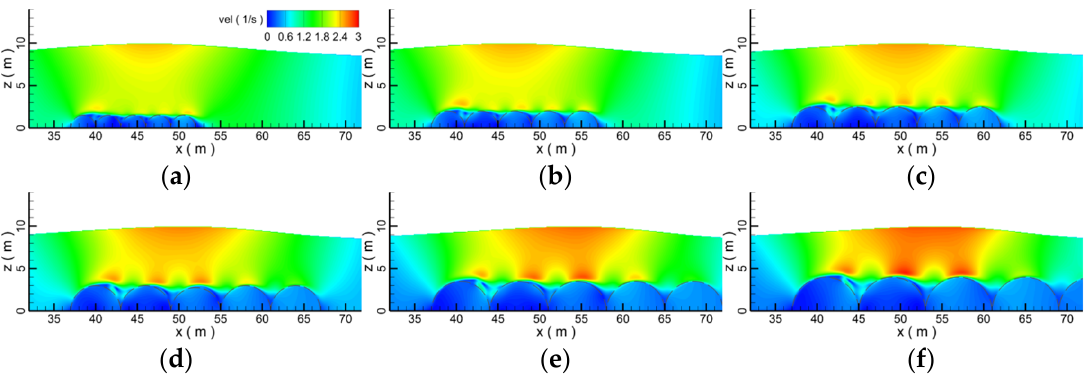
Figure 11. The velocity contour of the wave peak on the breakwaters under different diameters; ( a ) D = 1.5 m; ( b ) D = 2.0 m; ( c ) D = 2.5 m; ( d ) D = 3.0 m; ( e ) D = 3.5 m; ( f ) D = 4.0 m.